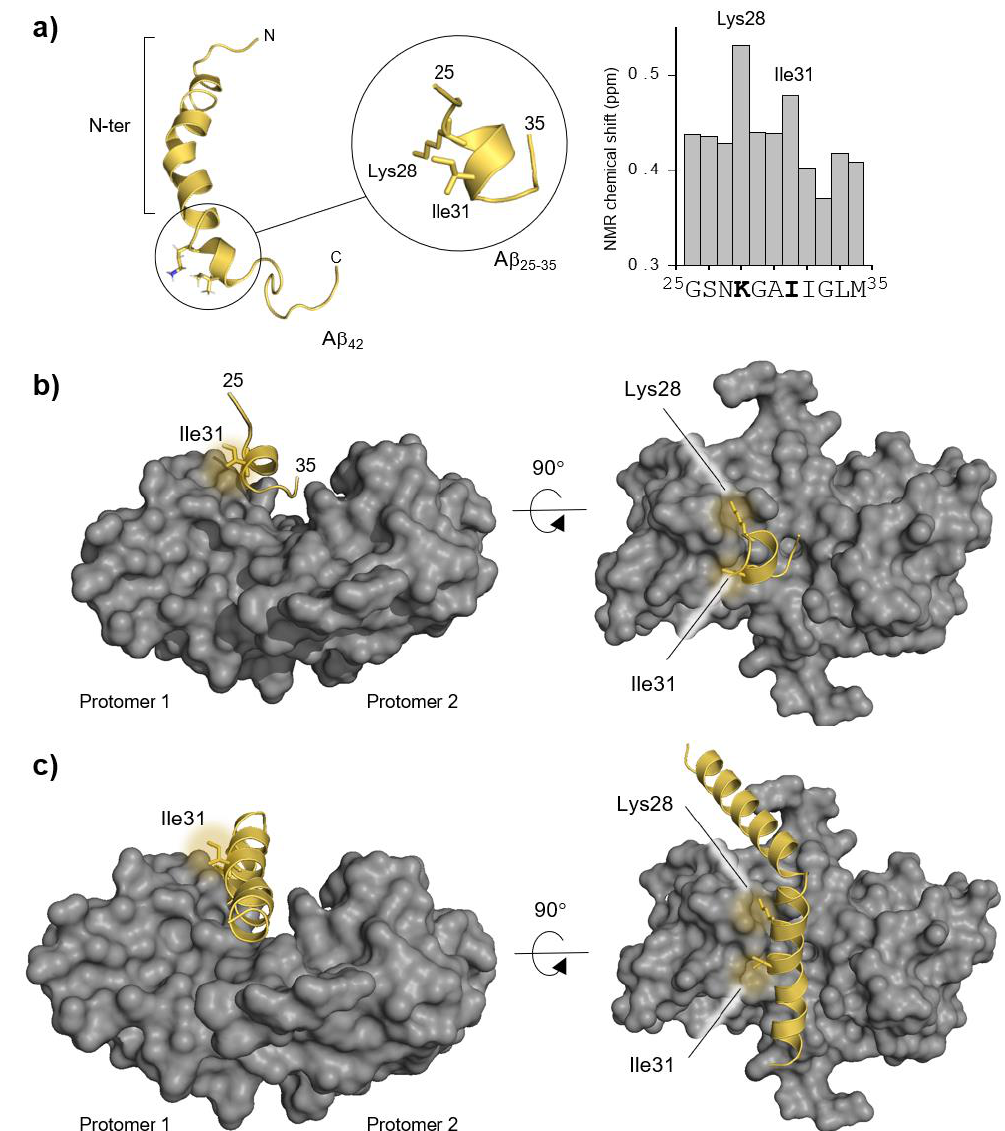
Figure 1. Molecular representations of Aβ42, Aβ 25–35 , S100B, and the main experimental data which guided the molecular docking procedure. ( a ) A β 42 peptide cartoon structure (Protein Data Bank, PDB entry 1Z0Q) obtained from NMR in a 30/70 ratio solution of hexafluoro-2-propanol/water [22] (Lys28 and Ile31 residues are depicted in sticks to highlight their spatial proximity) and the NMR-based experimental evidence showing Lys28 and Ile31 interacting with S100B (redrawn from NMR interaction data from [8]). ( b ) Haddock solution used in this study with the Aβ 25–35 structure located in the S100B (grey surface) binding cavity. ( c ) Full-length Aβ 42 rebuilt from the Haddock solution in α-helical conformation. N-ter: N- terminus.